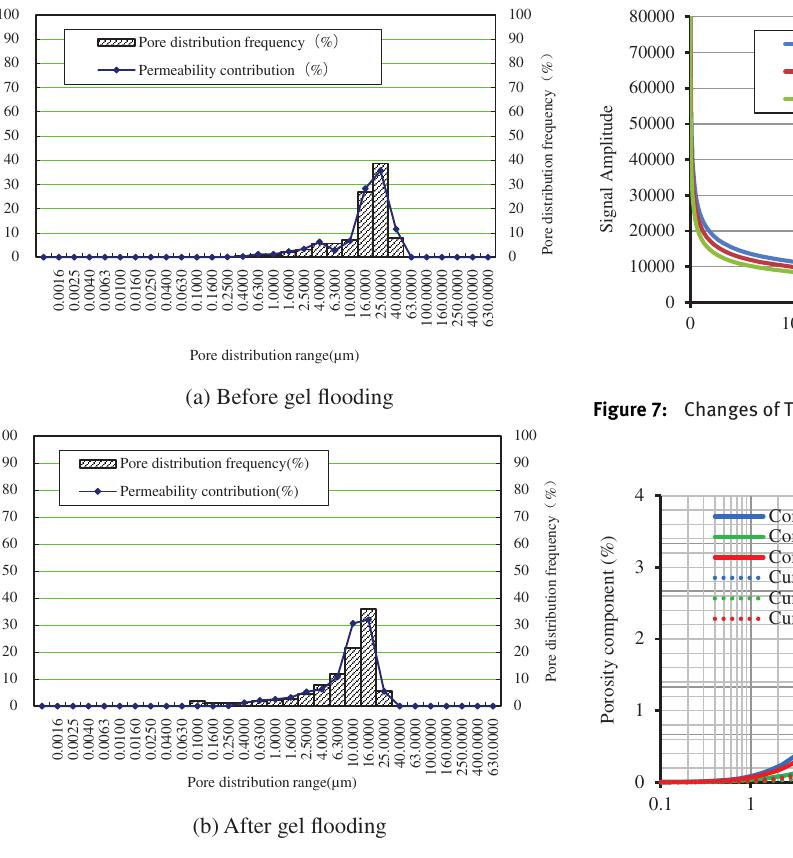
Figure 8: Porosity component distributions before and after gel